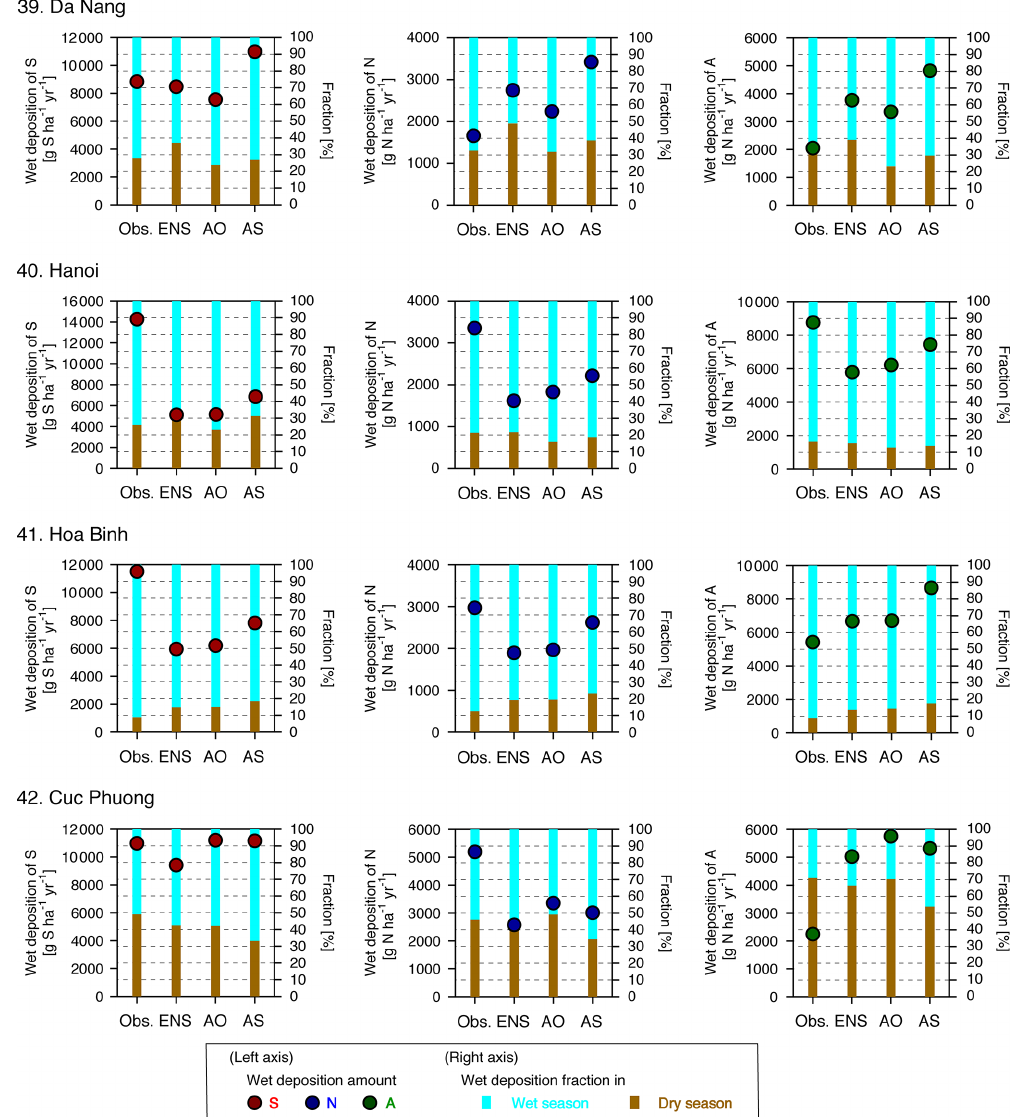
Figure 13. Observed and simulated annual accumulated wet deposition amounts of S, N, and A, and the fraction of wet deposition during the wet and dry seasons at four sites over Vietnam. The annual accumulated wet deposition amount is based on the months for which wet deposition observations were available (see Fig.